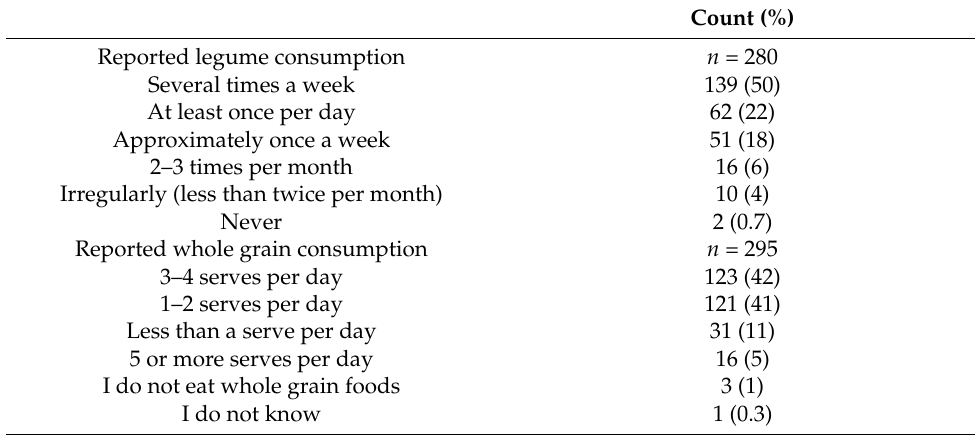
Table 2. Reported legume and whole grain